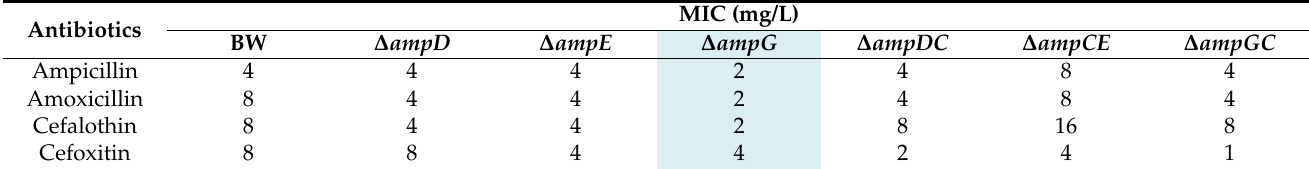
Table 1. Comparative beta-lactam sensitivities of wild type BW and single mutants of beta-lactamase induction genes— ∆ ampD , ∆ ampE and ∆ ampG